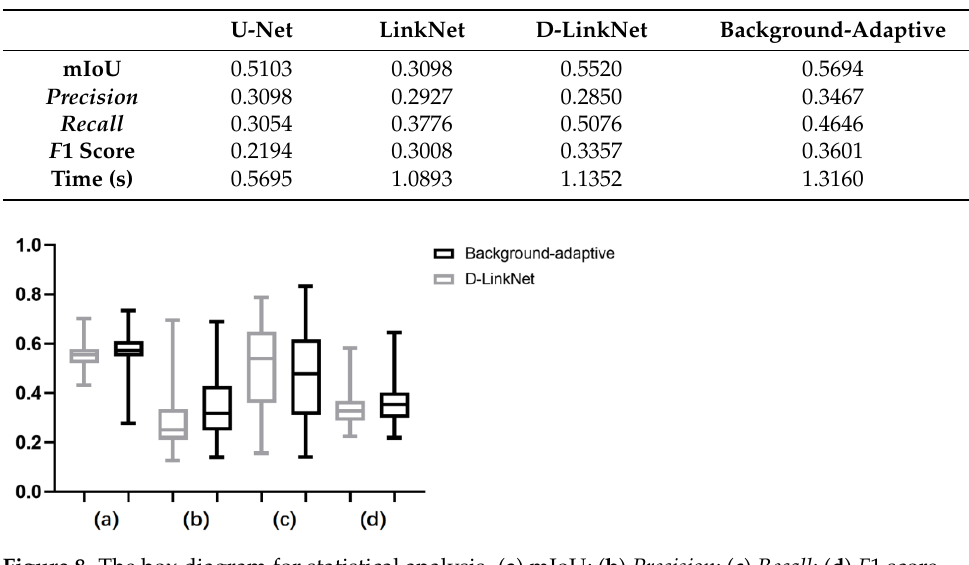
Table 3. Comparisons of the road extraction performance derived by each method.